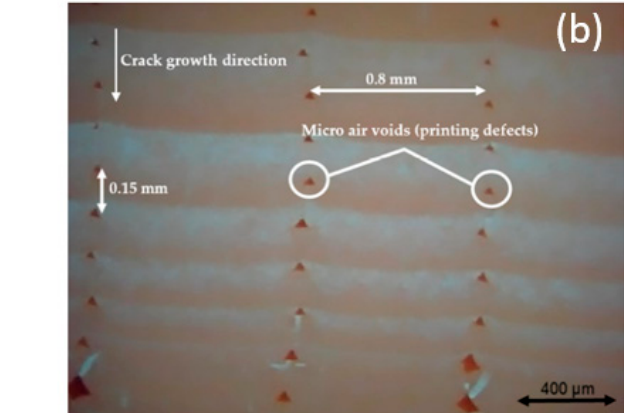
Figure 14. Comparison between the environmental temperatures influence on FCG rate of FDM ABS samples printed with (0.05-, 0.10-, and 0.15-mm layer thickness; 0.4-, 0.6-, and 0.8-mm nozzle sizes; and X, XY, and Y building orientations). Table 8. The mean FCG rate and number of cycles of different environmental temperatures regard- less of other printing parameters. Environmental Temperature (°C)